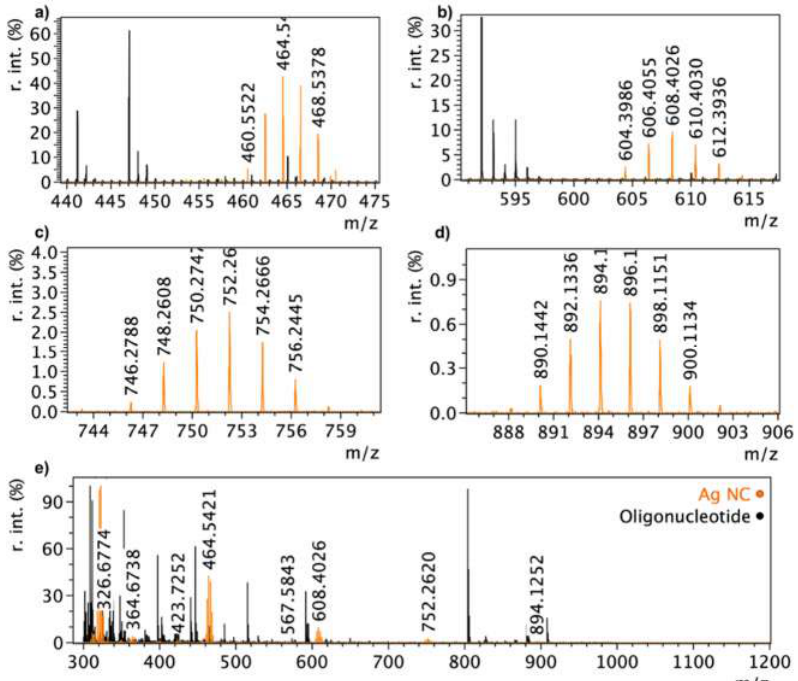
Figure 3. Corresponding MALDI-MS spectra for oligonucleotide on its own and Ag NCs showing 3–8 Ag atom Ag NCs ( e ) and zoomed regions of peaks of interest ( a – d ). The oligonucleotide on its own shows sets of three peaks in descending intensity, The Ag NC spectrum (orange peaks) contains distributions of peaks to Ag isotopes, and is missing the peaks associated with the oligonucleotide (black